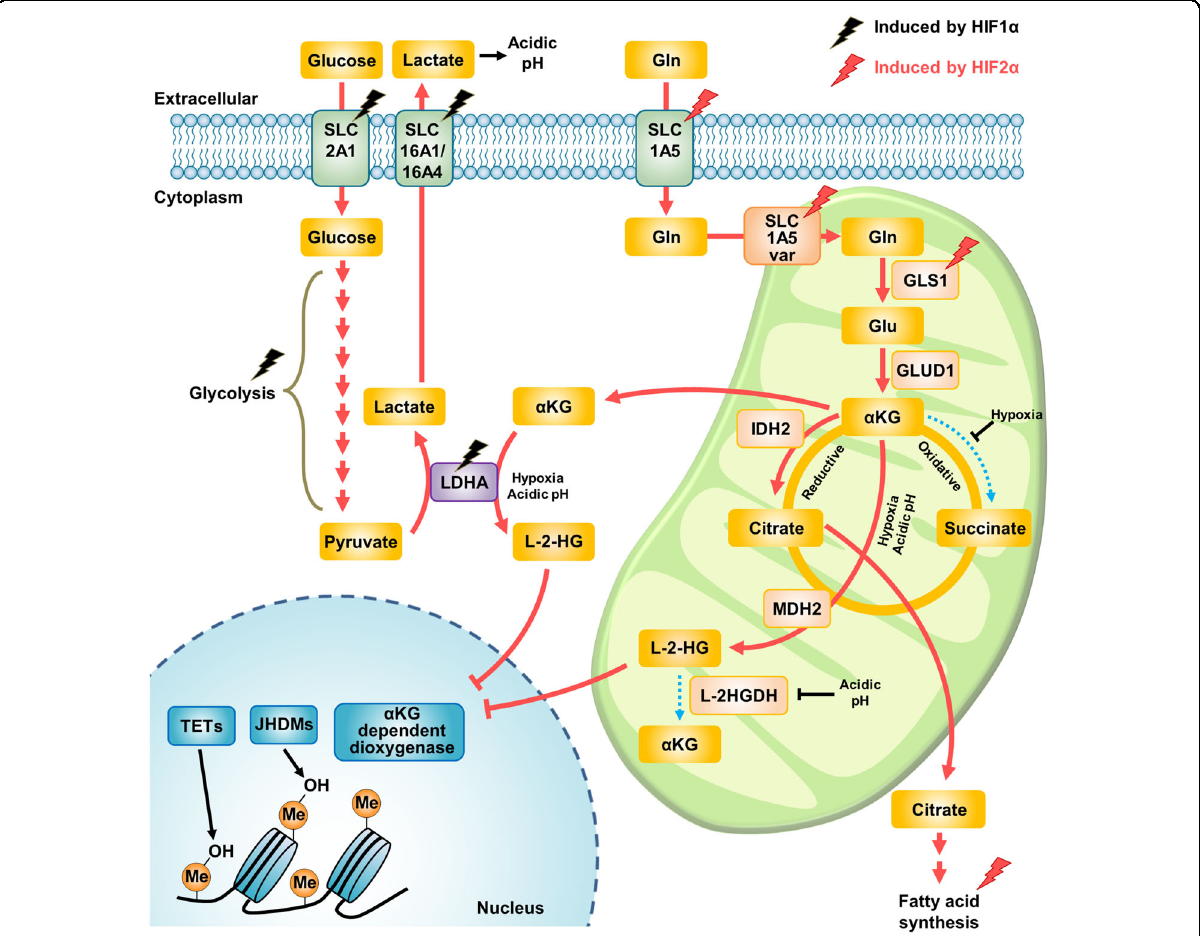
Fig. 4 Control of glutamine metabolism by hypoxia. Hypoxia stabilizes HIF- α proteins such as HIF-1 α and HIF-2 α . HIF-1 α enhances glucose uptake and increases the level of glycolytic enzymes. Under hypoxic conditions, most glucose-derived pyruvate is converted into lactate via LDHA and exported to the extracellular space through the lactate transporters SLC16A1 and SLC16A4. Under these conditions, HIF-2 α -mediated glutaminolysis becomes essential to support the adaptation to hypoxia, altering the metabolic fate of glutamine via reductive carboxylation to generate citrate. Then, citrate participates in fatty acid synthesis in the cytosol, which is also activated by stabilized HIF-2 α . Hypoxia-induced acidic pH also plays a crucial role in the production of L-2-HG by affecting the substrate af fi nities of LDHA and MDH. Next, L-2-HG can control DNA or histone methylation levels by regulating α -KG-dependent dioxygenases. HIF hypoxia-inducible factor, GLS glutaminase, GLUD glutamate dehydrogenase, IDH isocitrate dehydrogenase, MDH malate dehydrogenase, L-2HGDH L-2-hydroxyglutarate dehydrogenase, LDHA lactate dehydrogenase, TETs ten-eleven translocation enzymes, JHDMs JmjC domain-containing histone demethylases, Gln glutamine, Glu glutamate, α -KG α -ketoglutarate, L-2-HG L-2- hydroxyglutarate, Me